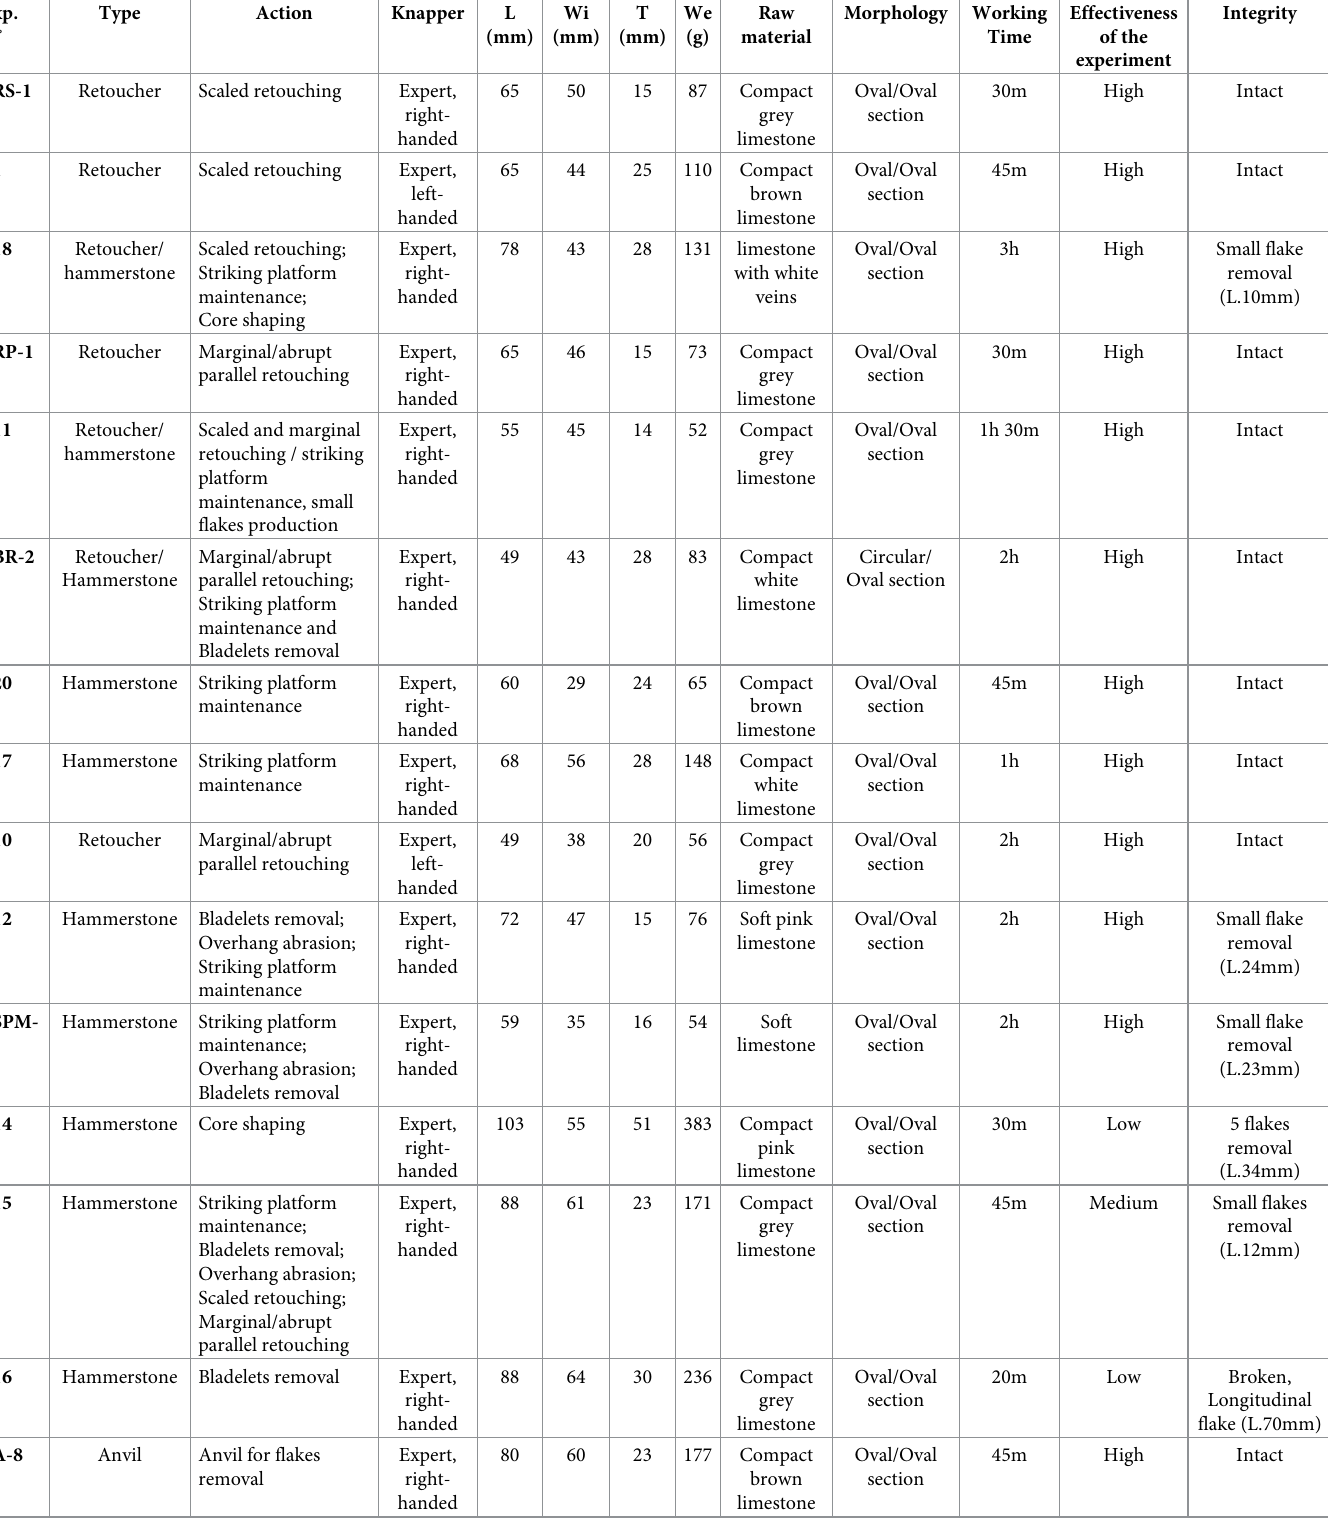
Table 2. List of experimental samples used in different phases of the chipped tools production. Exp.